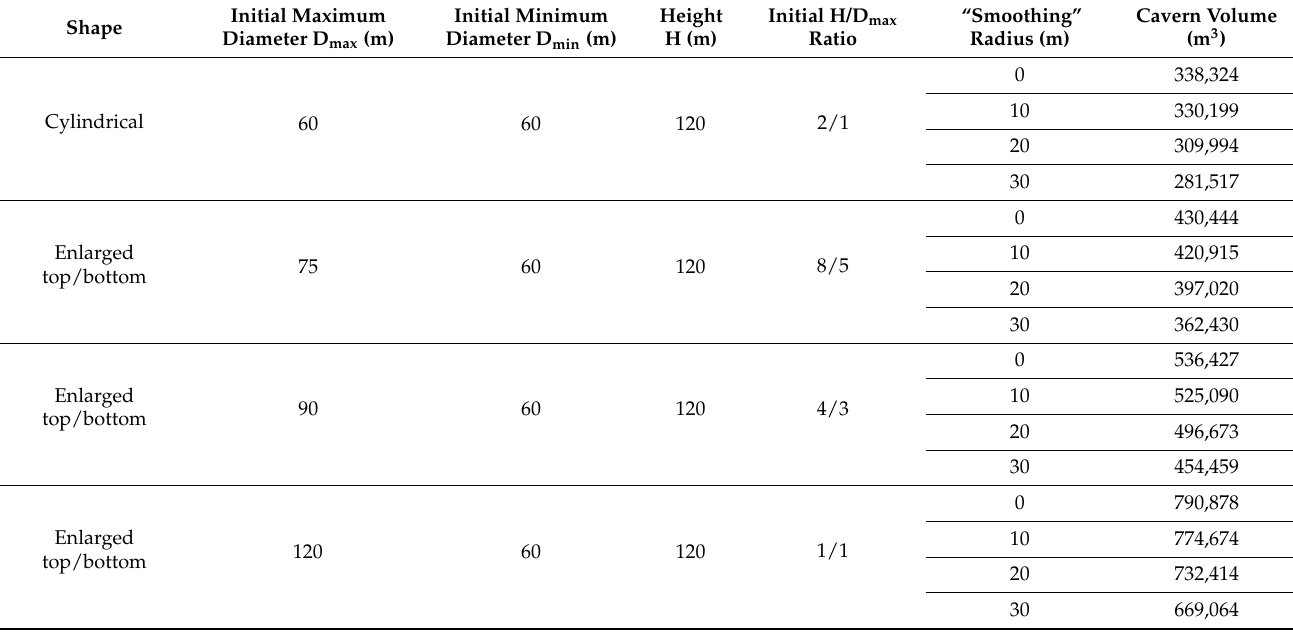
Table 1. Shapes and dimensions of simulated salt